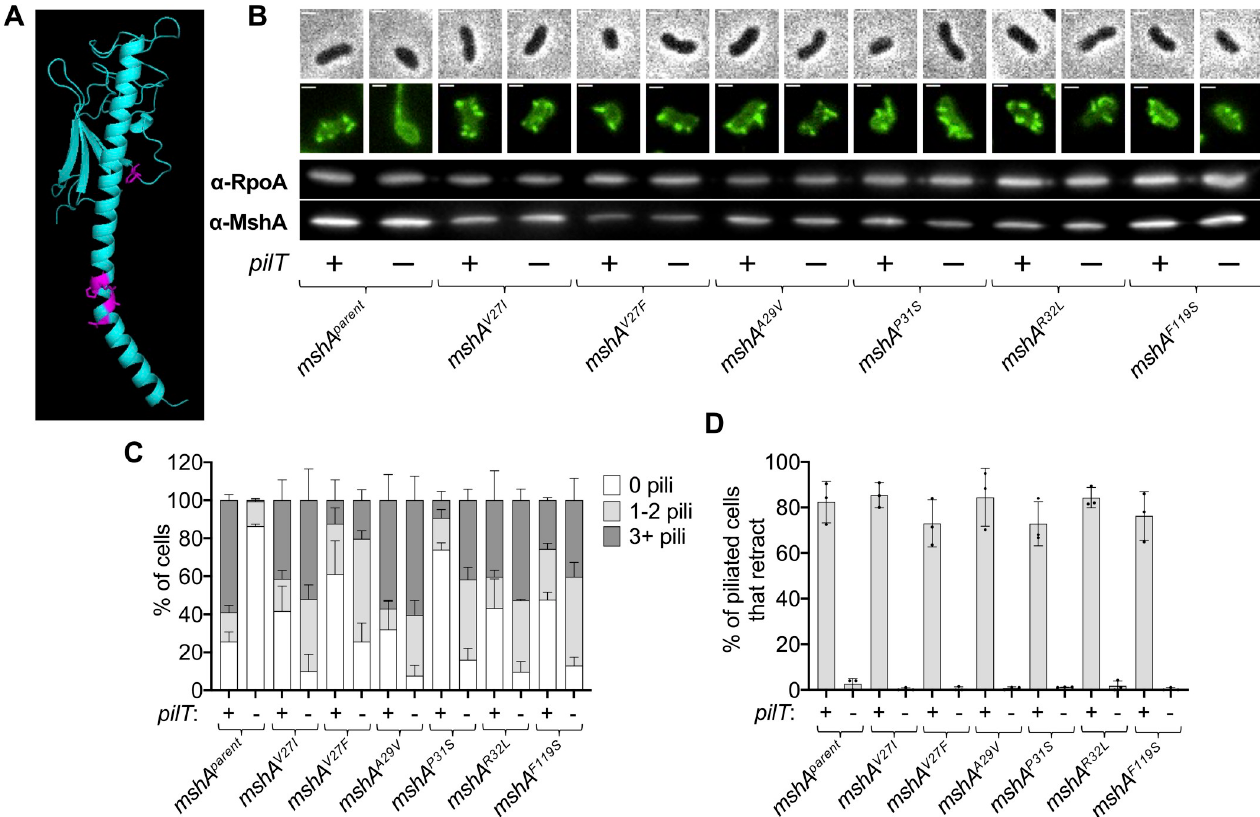
Fig 6. Point mutations in the major pilin mshA recover the piliation defect of a Δ pilT mutant. ( A ) Predicted structure of MshA, generated using AlphaFold [64,65].Residues mutated in the suppressor selection are colored magenta. ( B ) Representative images of piliated cells and Western blotting of MshA in suppressor mutants. RpoA is included as a loading control. Phase images (top) show cell boundaries and fluorescence images (below) show AF488-mal labeled pili. Scale bar = 1 μ m. In all panels, strains that retain native pilT are denoted “+” and strains with Δ pilT mutations are denoted “-”. ( C ) Quantification of piliation in strains from B . Cells were categorized as either having no pili (white bars), 1–2 pili (light gray bars), or at least 3 pili (dark gray bars). n = 300 cells analyzed from three independent biological replicates for all samples. ( D ) Quantification of retraction in strains from B . Data display the percentage of cells in each replicate that exhibited any pilus retraction during a three-minute timelapse. n � 25 piliated cells analyzed for each of the three biological replicates. Data in C and D are shown as the mean ± SD. Parent and Δ pilT data from Fig 1C are included for